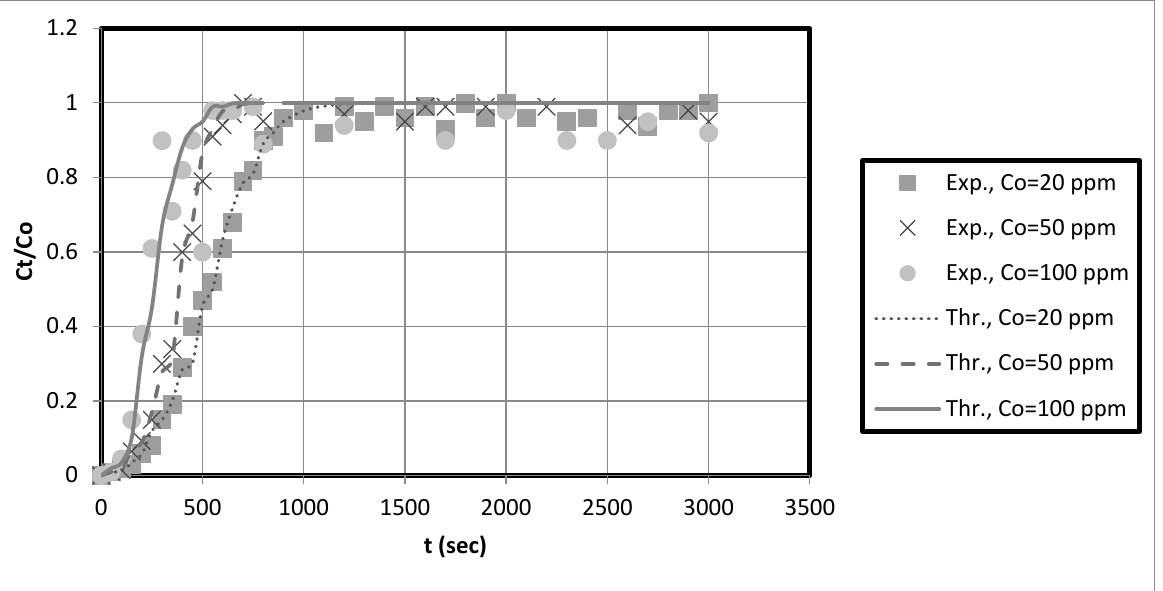
Figure 13. Axial pore diffusion model fit of the fixed-bed breakthrough curve for a nickel at different initial solution concentrations. Conditions: h = 0.05 m, us = 0.00473 m/s, kf = 0.000252 m/s, Dp = 2 × 10 − 9 , Dax = 3.53 × 10 − 6 m 2 /s, eb = 0.42, r = 0.000175